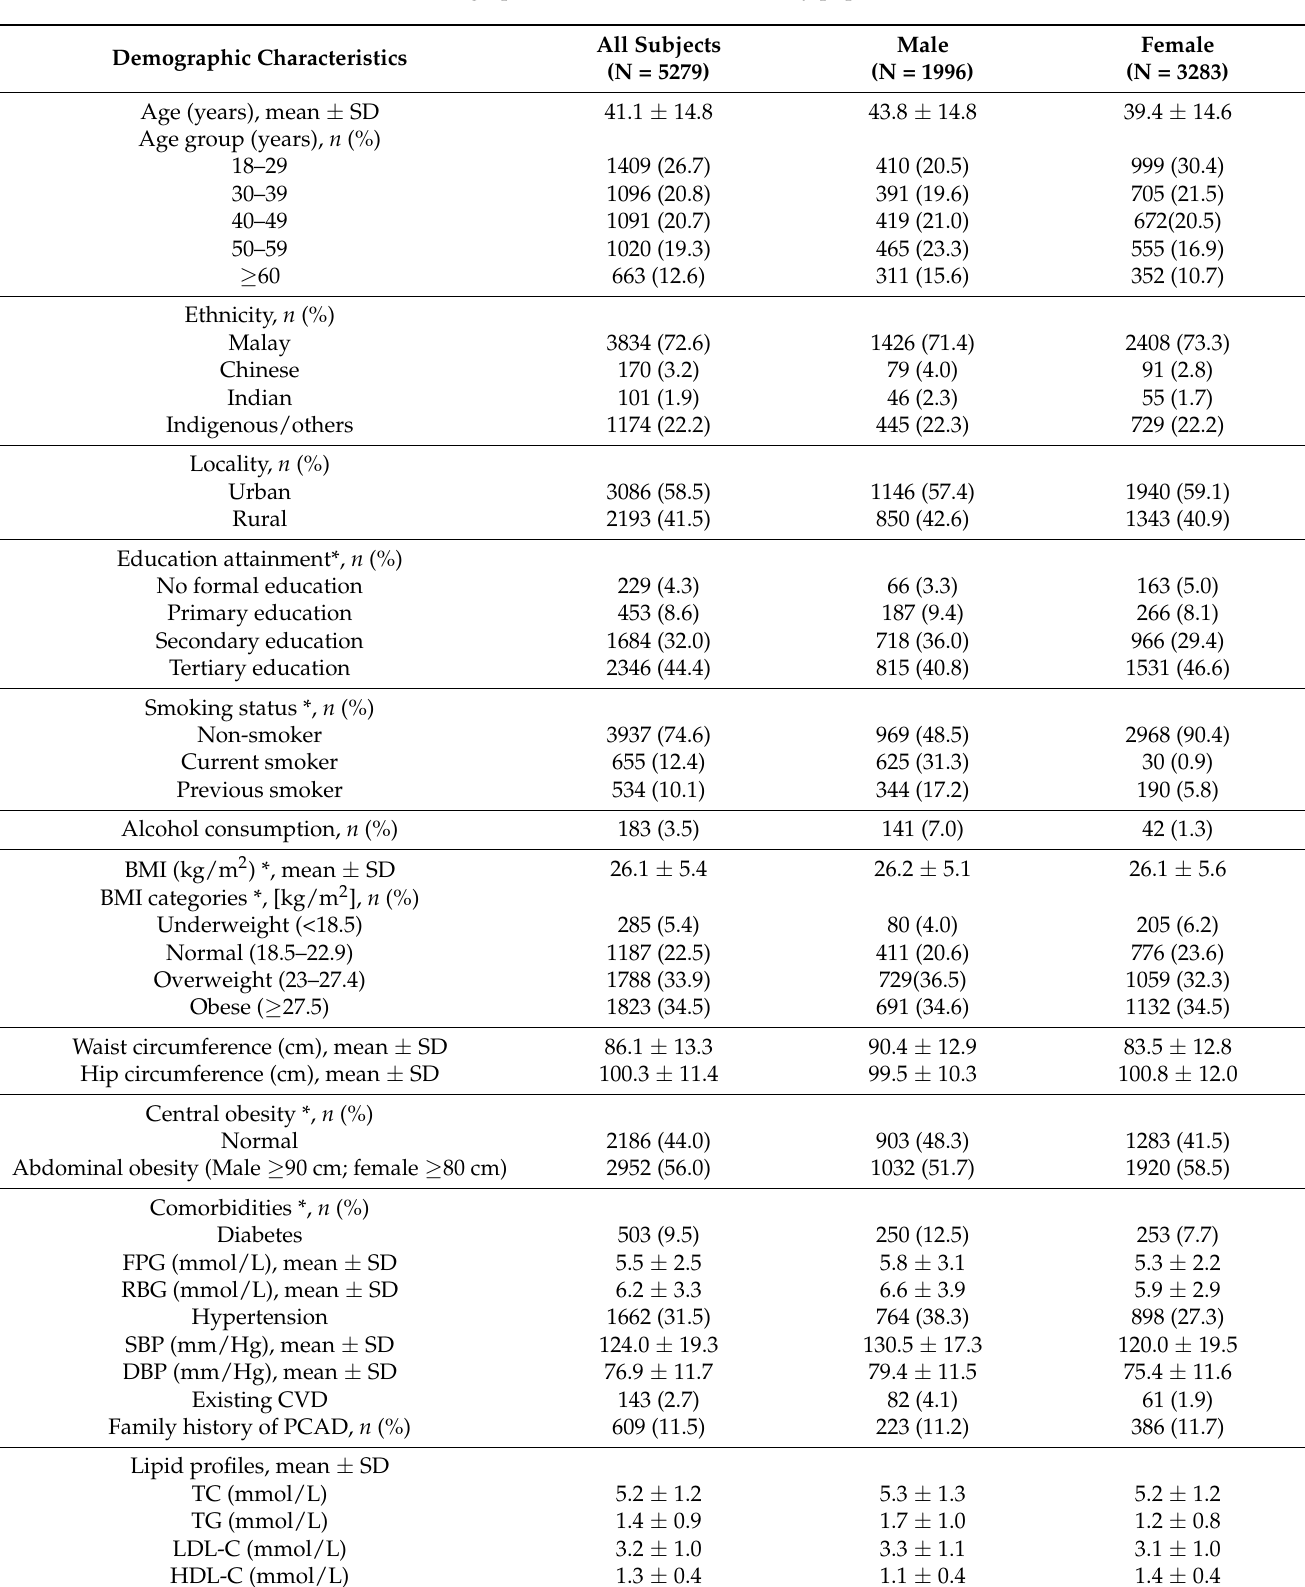
Table 1. Demographic characteristics of the study